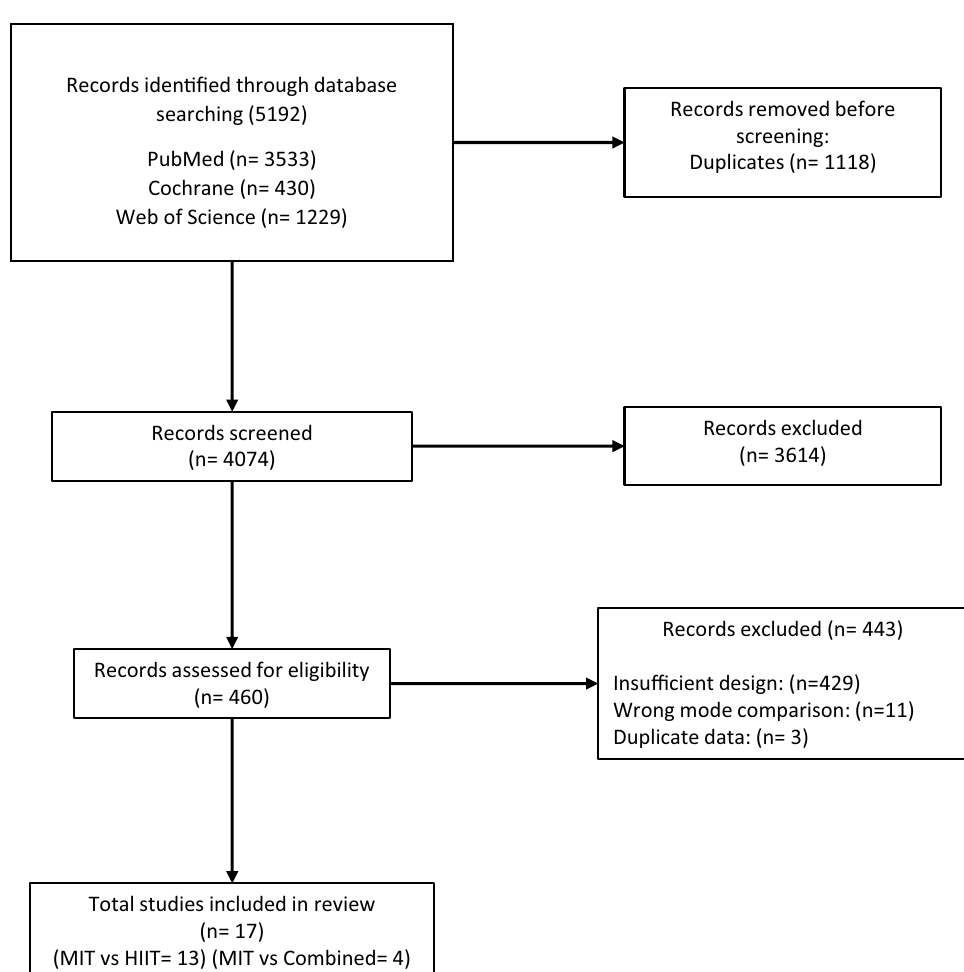
Fig. 1 PRISMA systematic review and meta-analysis flowchart. MIT, moderate intensity training; HIIT, high-intensity interval